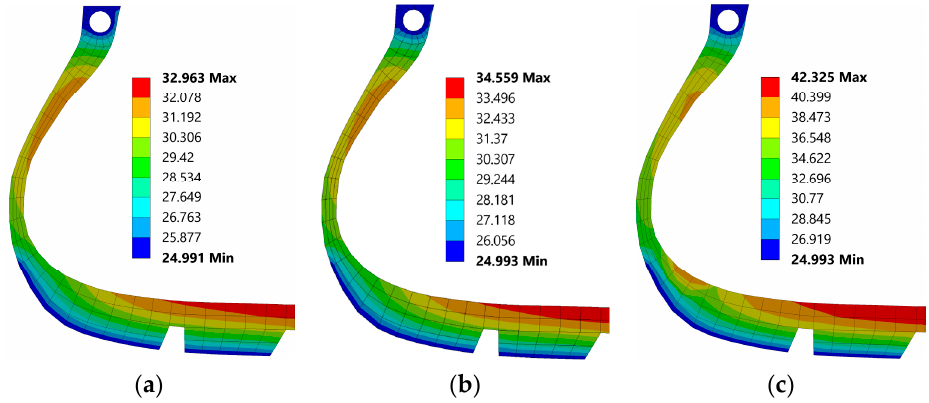
Figure 19. Distribution of temperature in rubber with di ff erent friction coe ffi cients (unit: °C): ( a ) 0.1; ( b ) 0.2; ( c ) 0.5.